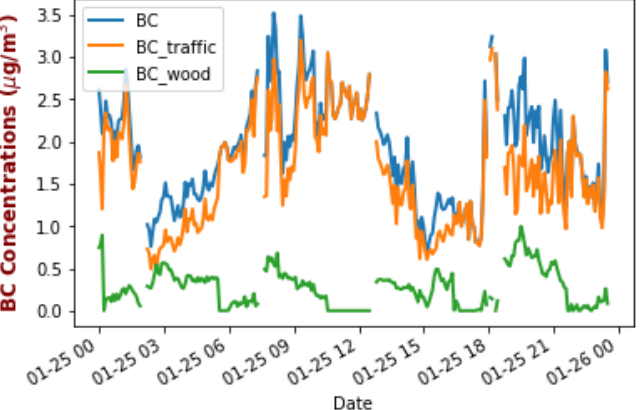
Figure 13. Temporal variation of the BC mass concentrations ( µ g/m 3 ) along with the contribution of the fossil fuel and wood burning to the total BC mass concentration on 25 January 2020.